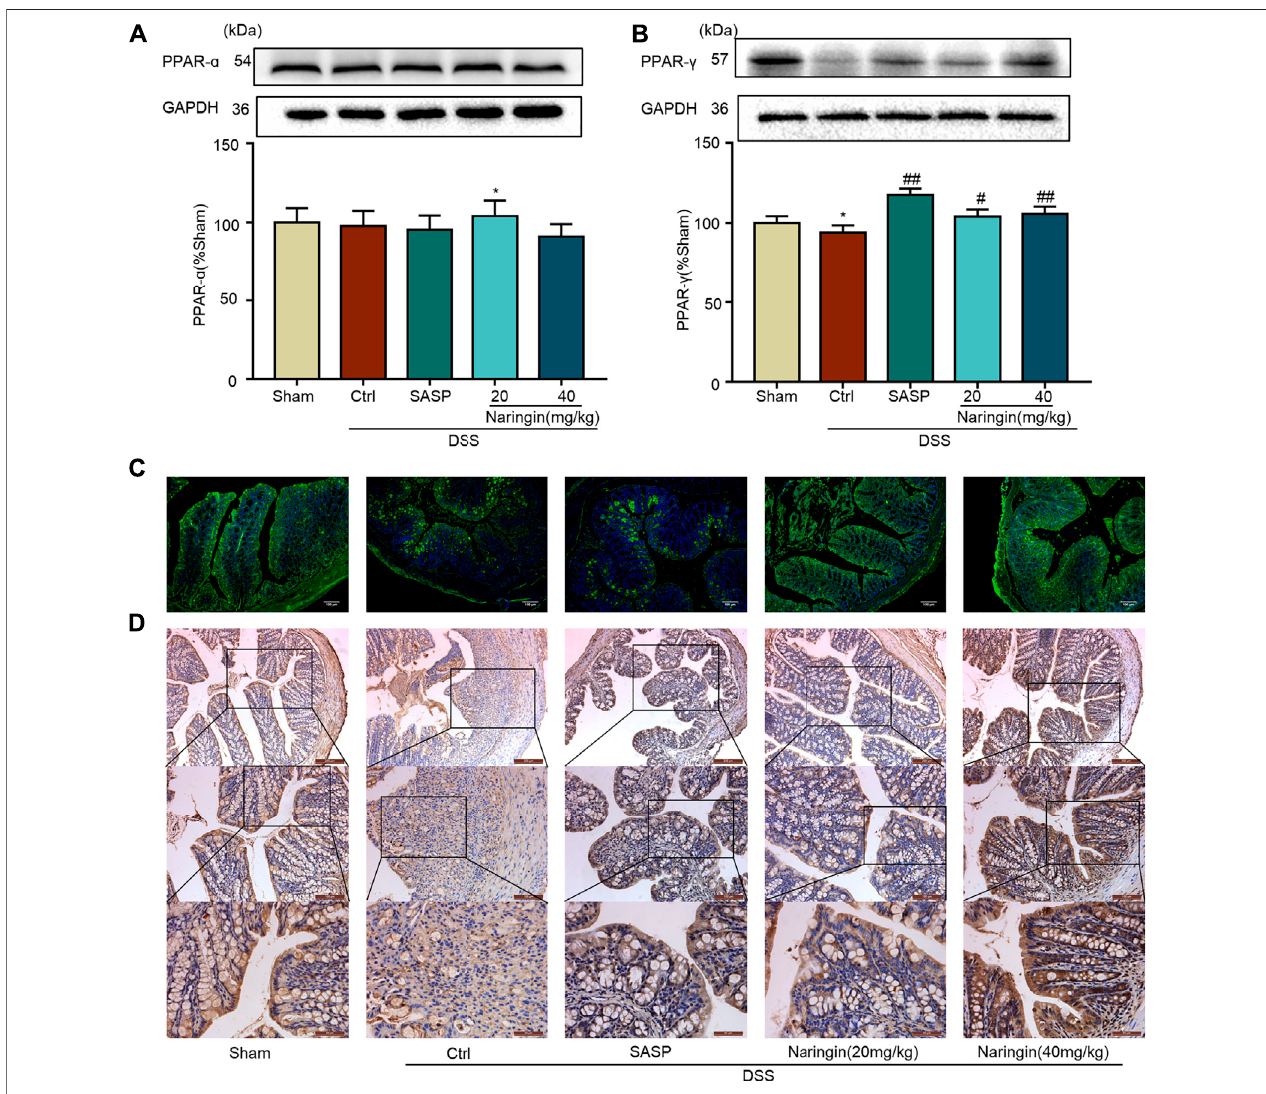
FIGURE 7 | Effects of naringin on PPAR- γ expression in DSS-colitis. Naringin was administered to mice by gavage once a day for seven consecutive days. (A) Western blotting analysis of PPAR- α . (B) Western blotting analysis of PPAR- γ . (C) IF staining of PPAR- γ in colonic epithelium. Scale bars, 100 μ m. (D) IHC staining of PPAR- γ incolonicepithelium.Scalebars,200,100,and50 μ m.Dataareexpressedasmean ± SD.Valuesintheshamgrouparesetto100%andothervaluesaregiven relative to those in the sham group. ** p < 0.01 compared with sham group; # p < 0.05, ## p < 0.01 compared with DSS-colitis group; n (cid:2) 3 samples in western blottingexperiments; n (cid:2) 6samplesforotherexperiments. Theseblotsarecropped,andthefull-lengthblotsarepresentedisinthe SupplementaryFiguresS10 – S13 .